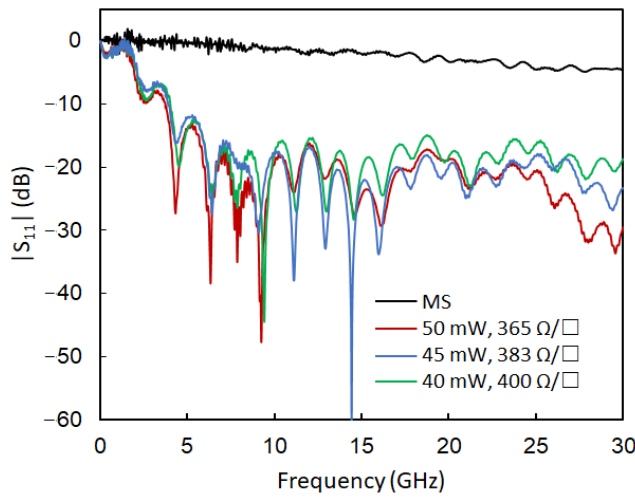
Figure 8. The measured |S 11 | of the laser-scribed terminations. Additionally, the S-parameters of the laser-scribed termination at two-port configu- rations is measured, as plotted in Figure 9. The terminations can provide over a − 10 dB attenuation level (|S 21 |) at frequencies above 8.5 GHz. The reflection level is low as < − 10 dB at frequencies above 1.7 GHz and < − 15 dB at frequencies above 2.0 GHz. Thus, the laser-scribed termination is a possible application for attenuation purposes.